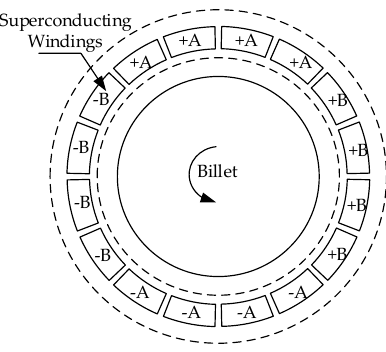
Figure 3. Cross section of two poles induction heater configuration. Symbols +A, −A, +B, and –B indicate the phases and polarities of the current in the windings.